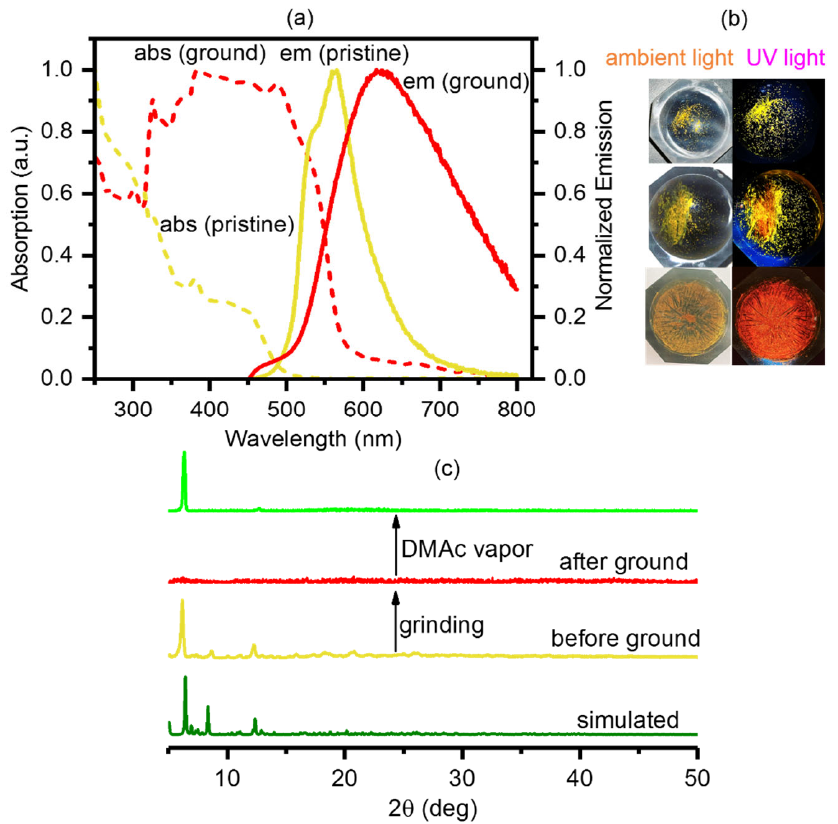
Figure 5. ( a ) The normalized UV-Vis absorption (dash) and emission (solid) spectra of Au 4 Cu 2 clus-ter before and after mechanical grinding. ( b ) The images of Au 4 Cu 2 cluster under ambient light and UV light irradiation (365 nm) before and after mechanical grinding. ( c ) The simulated and measured X-ray di ff raction pa tt erns of Au 4 Cu 2 cluster upon mechanical grinding and DMAc vapor adsorption.